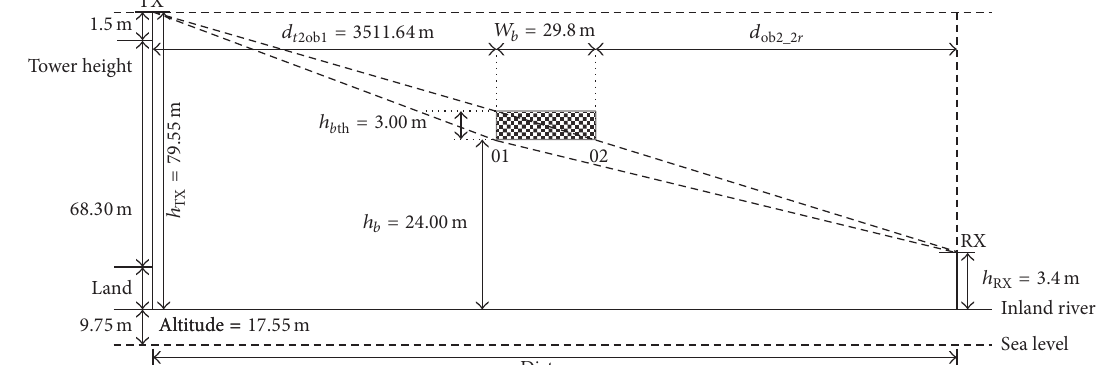
Figure 11: Diffraction under the bridge.